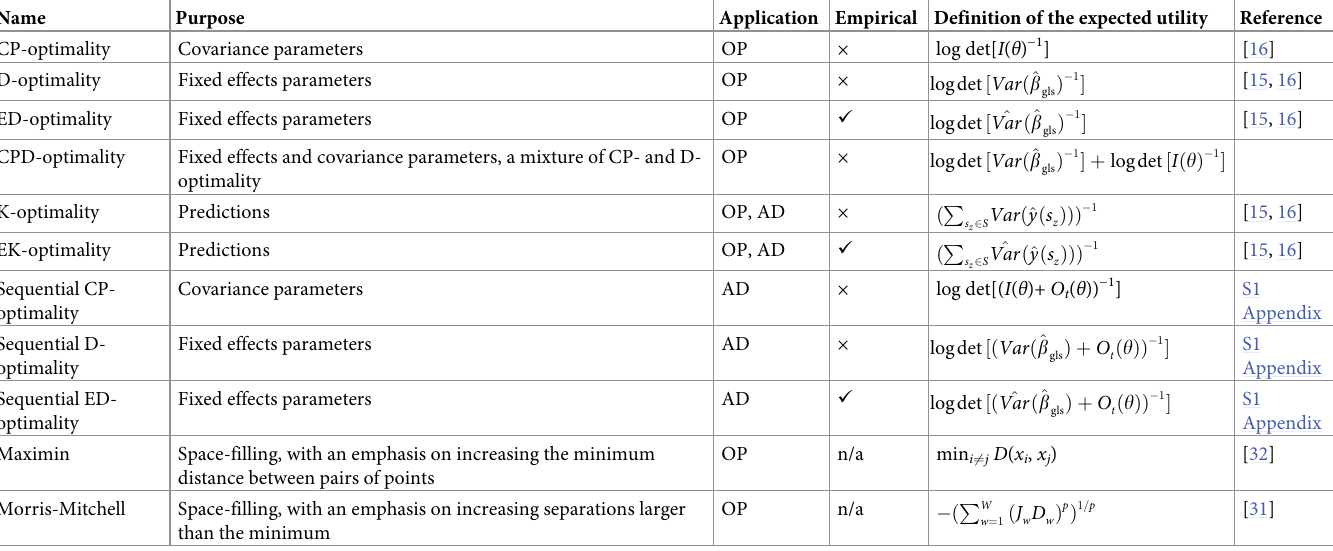
Table 1. Utility functions implemented in SSNdesign . Empirical utility functions are utility functions where the covariance parameters are estimated from data simulated using the prior draws . θ = a vector of covariance parameters from a geostatistical model; and y = data that is either directly observed from a process or simulated from it. OP = optimal design; AD = adaptive design. n/a = no covariance parameters involved. I ( θ ) = the expected Fisher Information Matrix; ^ b ¼ the estimates of the fixed effects ; Var ð ^ b Þ ¼ covariance matrix for the fixed effects . s = a prediction site; S = the set of all prediction sites. z gls gls ^ y ð s Þ ¼ the predicted value at a prediction site . Var ð ^ y ð s ÞÞ ¼ the kriging variance . O t ( θ ) = a summary statistic from the existing design. D ( x i , x j ) = the distance z z between two points x i and x j . The distance can be measured as Euclidean distance or hydrological distance along the stream network [10]. D = a sorted vector of non-zero distances in a distance matrix; J = the number of times each distance occurs in one triangle of the matrix. The subscript w = 1, 2, ... , W counts the W unique non-zero entries in the distance matrix. p = a weighting power, with p � 1. In the Empirical column, × means No, ✓ means